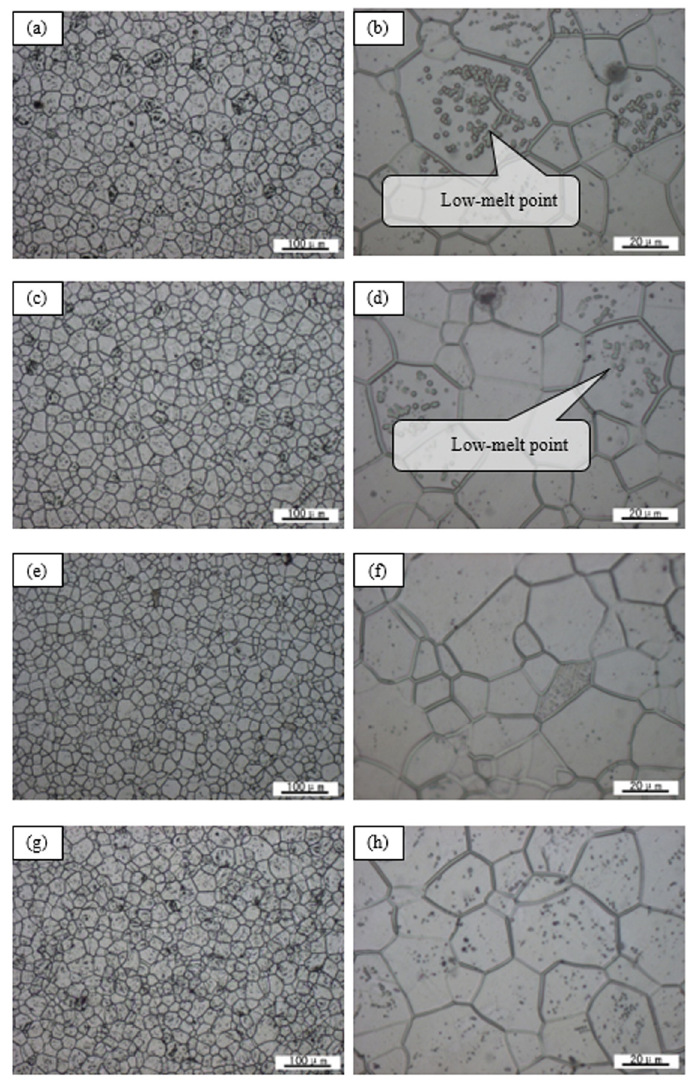
Figure 9. Optical microstructure of as-extruded GWK-a through different aging process ( a , b ) 200 °C/12 h; ( c , d ) 200 °C/24 h; ( e , f ) 200 °C/64 h; ( g , h ) 200 °C/72 h. ( a , b ) 200 ◦ C/12 h; ( c , d ) 200 ◦ C/24 h; ( e , f ) 200 ◦ C/64 h; ( g , h ) 200 ◦ C/72